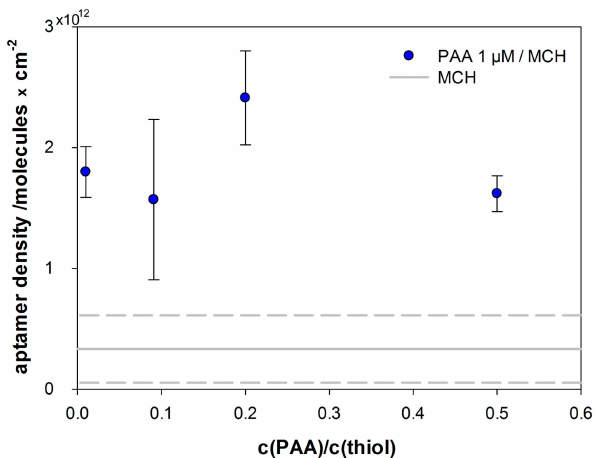
Figure 2. Aptamer density on the electrode surface depending on the protein A-binding aptamer (PAA)/ 6-mercapto-1-hexanol (MCH) molar ratio upon immobilization based on four experiments for each ratio; the grey lines show the average density and standard deviation determined for a MCH